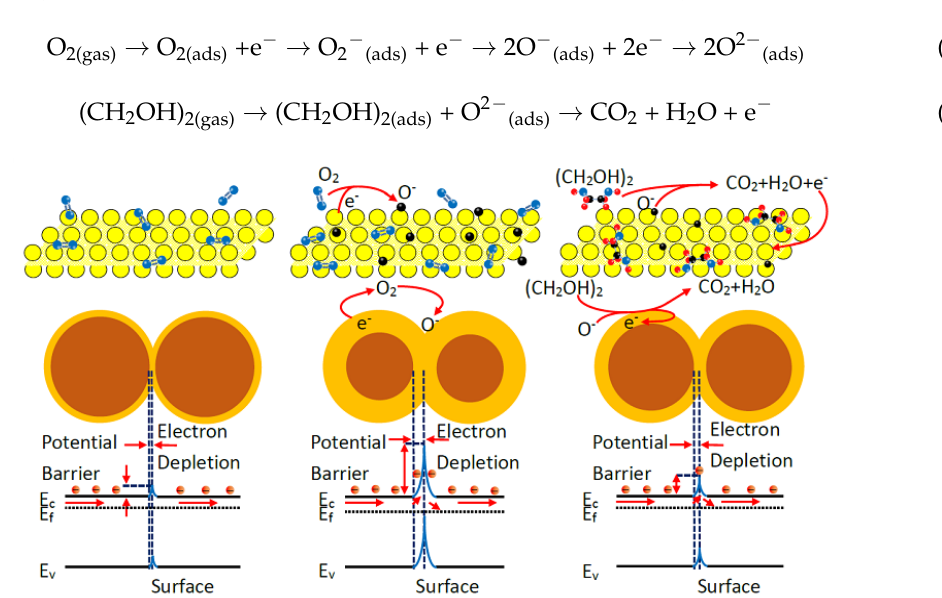
Figure 15. The schematic illustration of the sensing mechanism of SnO 2 nanosheets to ethylene